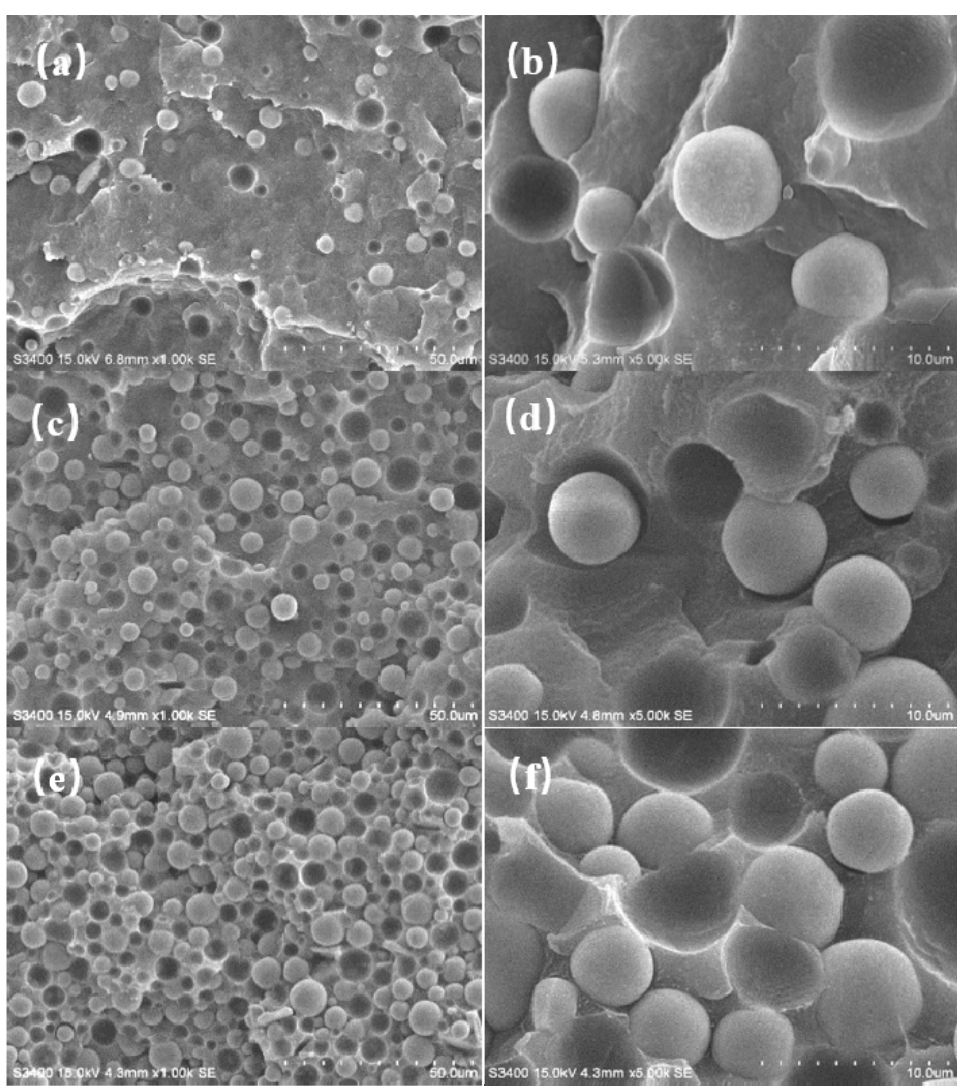
Figure 6. SEM micrographs of LLDPE/Al 2 O 3 composites with different Al 2 O 3 volume fractions: ( a , b ) 9.8 vol.%; ( c , d ) 27.6 vol.%; ( e , f ) 32.5 vol.%.